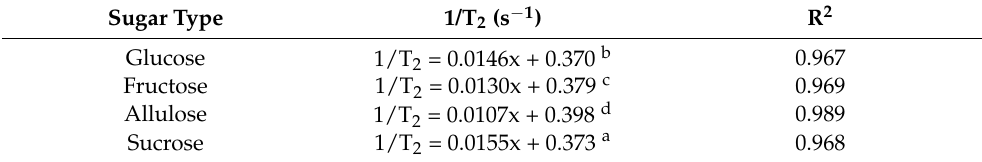
Figure 1. Relaxation rates (1/T 2 ) (s − 1 ) of sugars at different concentrations (%) (Data for 1/T 2 are expressed as mean ± SE ( n = 3)). Table 1. Model fitting for relaxation rates, 1/T 2 (s − 1 ) with respect to sugar concentration in the